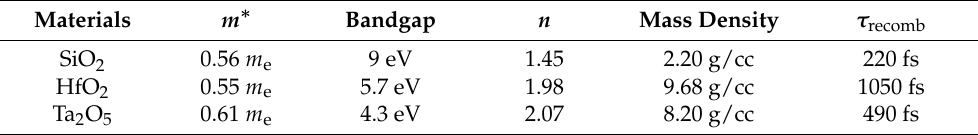
Table 1. Material parameters for simulation